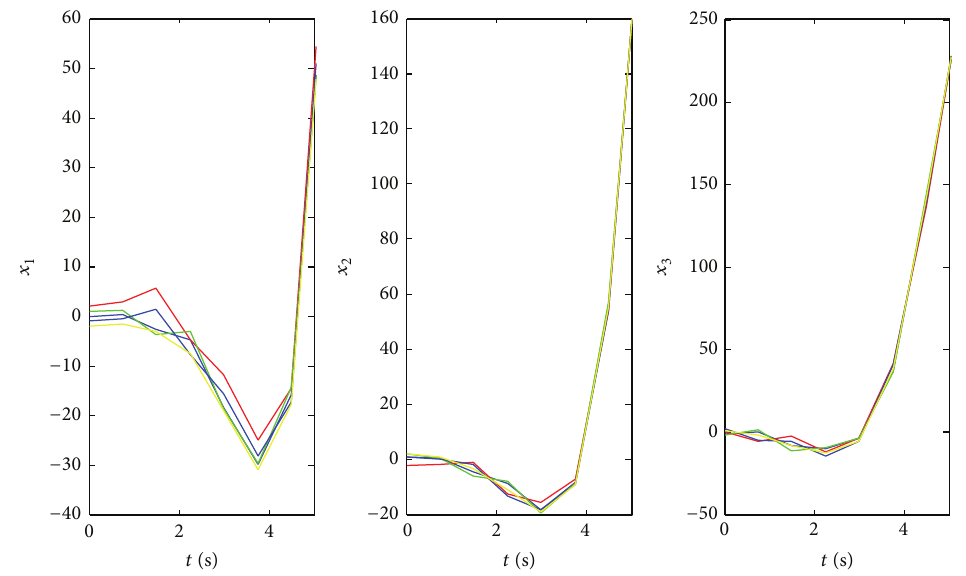
Figure 4: Trajectories of multi-input agents under fixed topology.